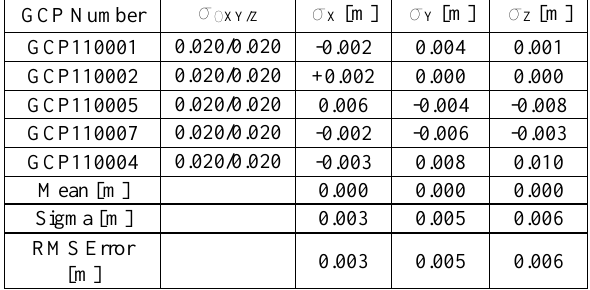
Table 4. Residuals of the ground control points